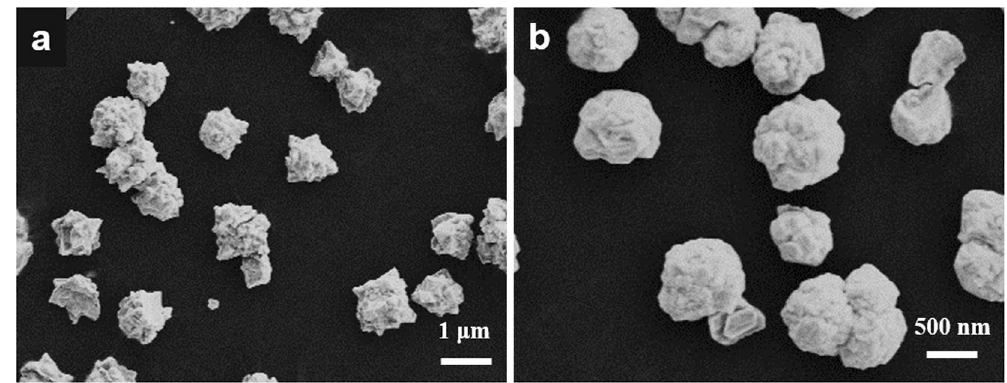
Figure 6. FESEM images of prepared AuPt nanoparticles in the ethaline with water content of ( a ) 50% and ( b )